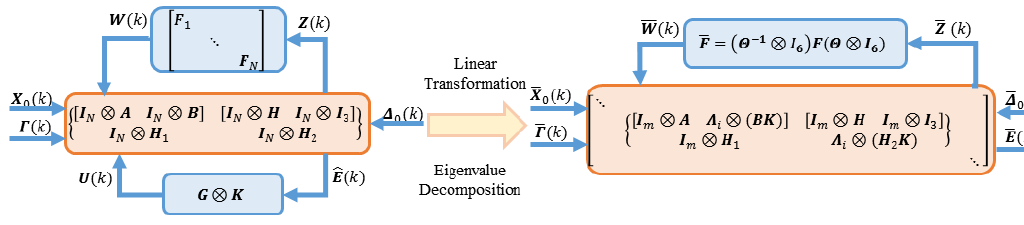
Figure 3. Fundamental of platoon decoupling.